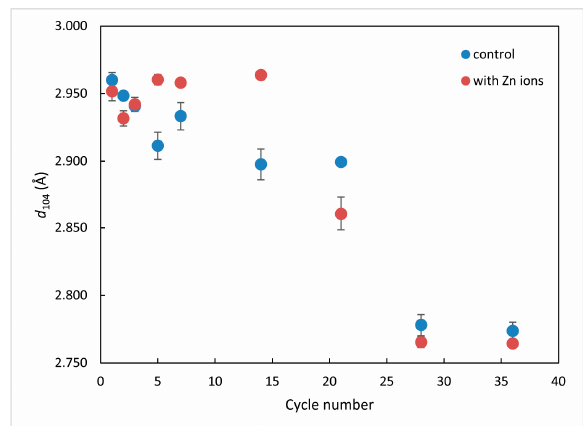
Figure 4. Plot presenting the evolution of the relative abundance of minerals in the reaction products versus cycle number for the first (control) series of pH cycling experiments. The quantification is based on Rietveld analysis of X-ray diffraction data. The error bars (in light grey) reflect the standard deviation of the results from the triplicate experiments.